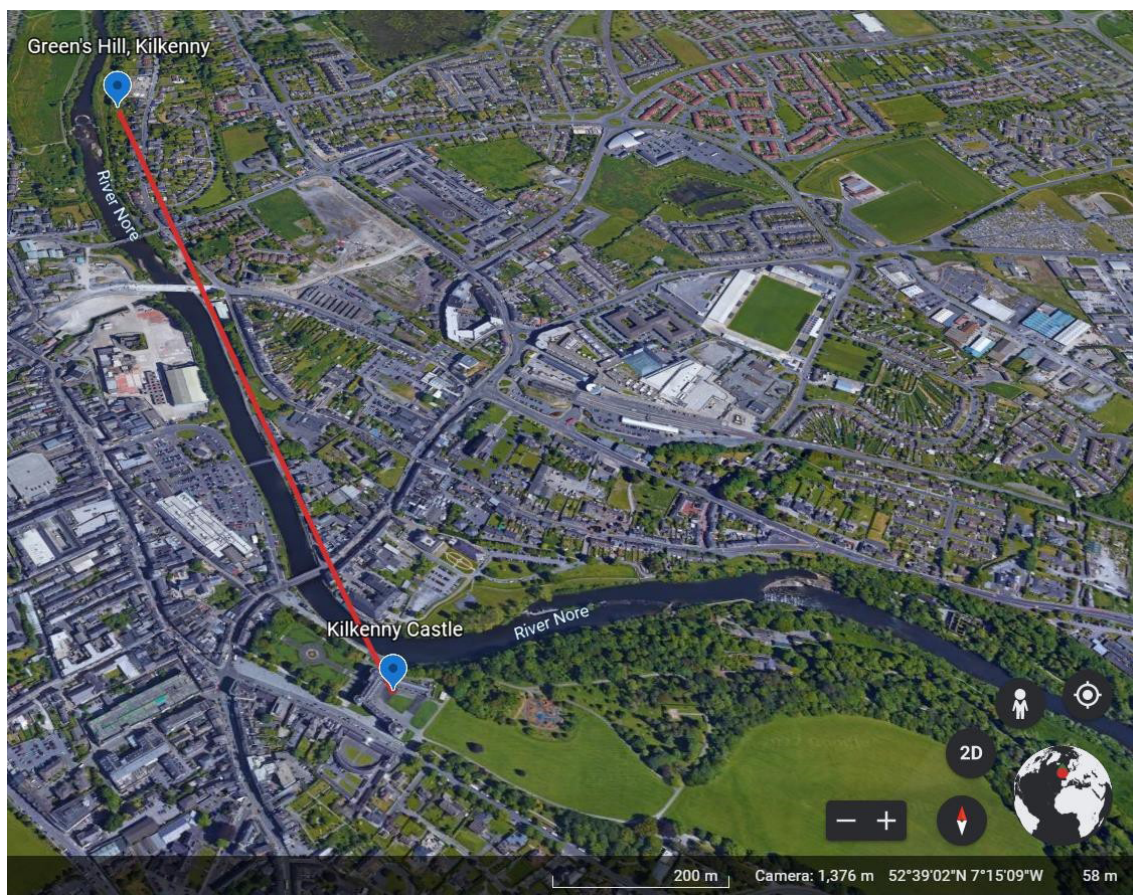
Figure 6. Illustration of the relative positioning of Kilkenny Castle and Greenshill, Kilkenny (©Google Earth, 2022).